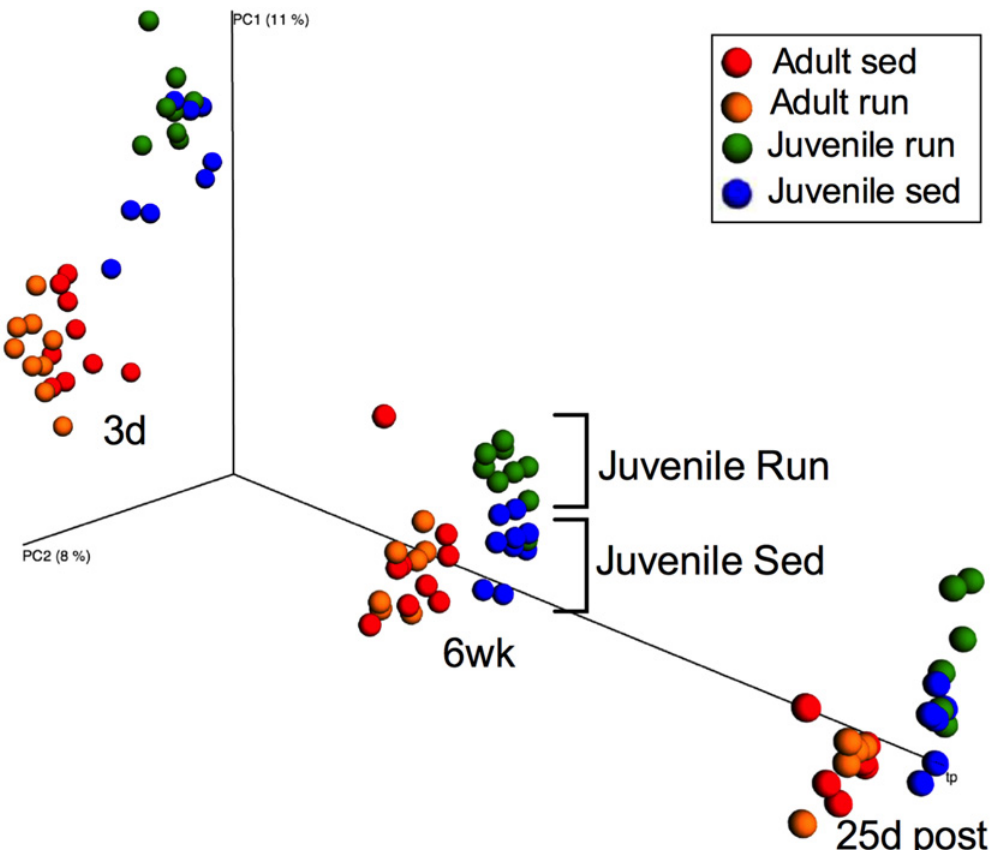
Fig 3. Early life exercise and age altered beta diversity. Principle coordinates analysis (PCoA) using unweighted UniFrac distances with an explicit time axis depicts clustering of microbial communities due to age after three days (3d) and six weeks (6 wk) of exercise and 25 days following exercise cessation (25d post). After 6 wk, a clear clustering of juvenile run versus juvenile sed samples is noticeable.